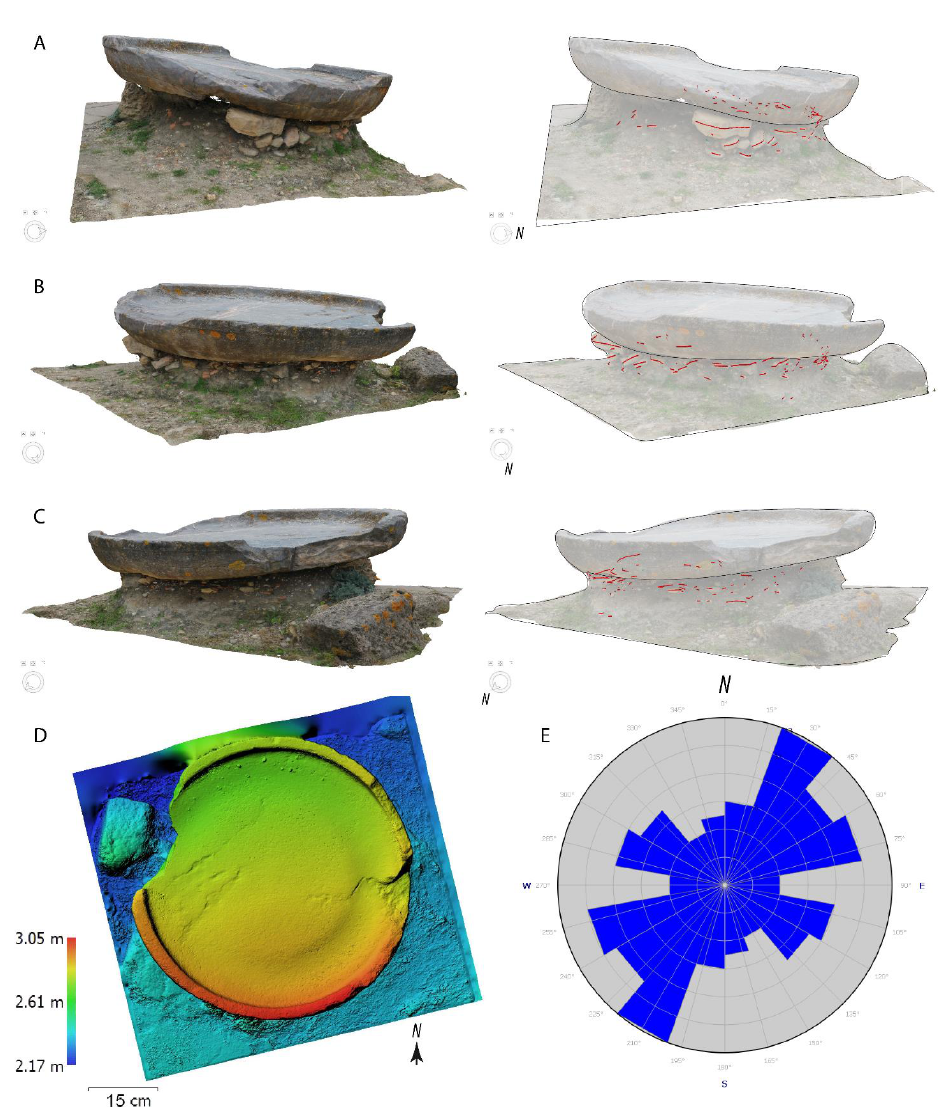
Figure 8. ( A ) View from the E of the tsunamite deposit with the bath dish on top (left) and 3D map distribution of the long axis of the largest clast embedded in the tsunami deposit (right). ( B ) View from the NNE of the tsunamite deposit (left) and 3D map distribution of the long axis of the largest clast embedded in the tsunami deposit (right). ( C ) View from the NNW of the tsunamite deposit (left) and the 3D map distribution of the long axis of the largest embedded clast (right). ( D ) Hypsometry in plan view of the tsunami deposit with the Roman bath dish in the first plane. Note the gentle slope indicating that the surface of the dish is dipping towards the N. ( E ) Rose diagram of the direction of the mapped long axis of the largest clast (69 in total) embedded in the tsunamite deposit, indicating a NE – SW transport direction.